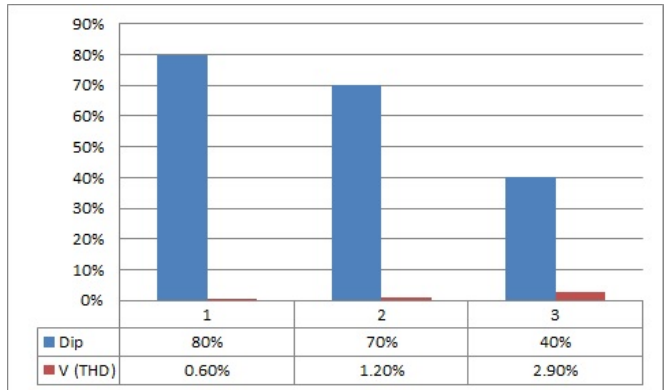
Figure 7. Current THD of induction motor under no load conditions [neutral connected].